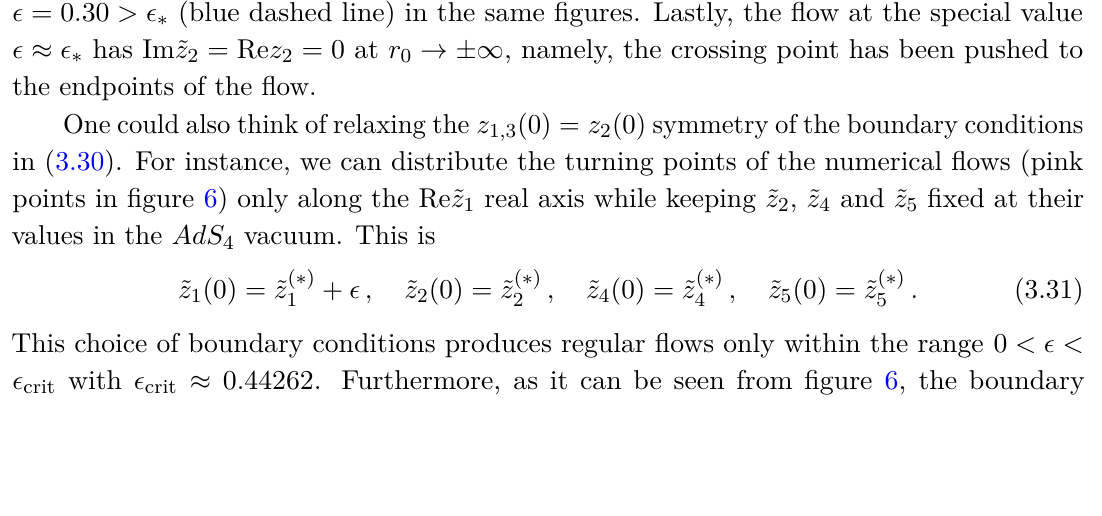
(top-left), ˜ z (top-right), ˜ z (bottom-left) and ˜ z 1 2 4 5 vacuum and the D3-brane asymptotics are denoted by 4 = ˜ z are 4 5 of the type IIB dilaton in the D3-brane asymptotics 0